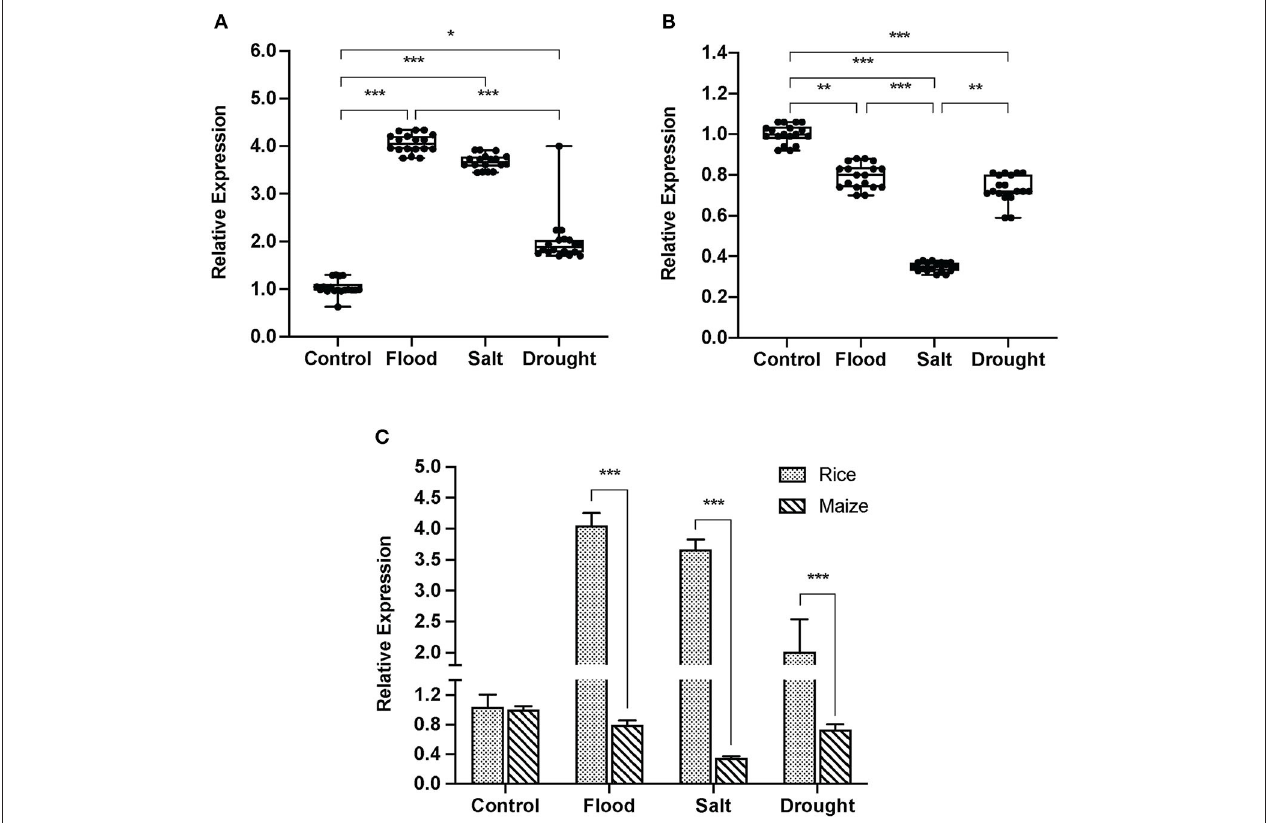
FIGURE 3 | Relative expression of group-1 expansin, β -expansin in the experimental rice and maize pollen. The expression was relative to the reference genes: ACT ( ACT1 for rice and ACT2 for maize) and UBQ ( UBQ10 for rice and UBQ7 for maize). The box plot showed the relative expression of the experimental rice (A) and maize (B) under either untreated, flood-, salt-, or drought-treated conditions. Box plots with error bars represent median and interquartile range. The comparative diagram (C) showed the mean relative expression of β -expansin in the experimental rice and maize. Bars with error bars represent mean and SD. A statistically significant difference tested by Kruskal-Wallis test with Dunn’s multiple-comparison test was indicated with the following asterisks: *( p < 0.05), **( p < 0.005), and ***( p <